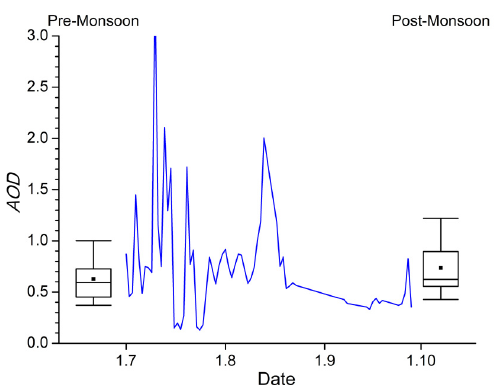
Fig. 10. Aerosol optical depth, AOD at 500nm, measured with the Cimel sunphotometer during 2009 in Gual Pahari. Line is daily av- erages, box plots denote pre- and post-monsoon seasonal values of 10%-ile, 25%-ile, median (line), average (dot), 75%-ile and 90%-